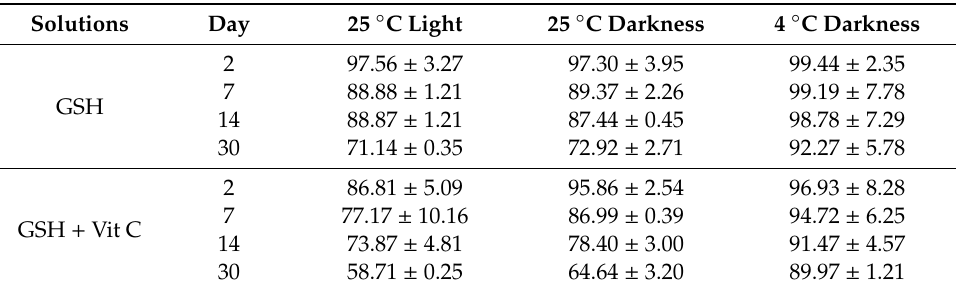
Table 2. Stability results obtained for GSH solution and GSH + Vit C solution. Concentration mean as a percentage of original concentration ± SD ( n =